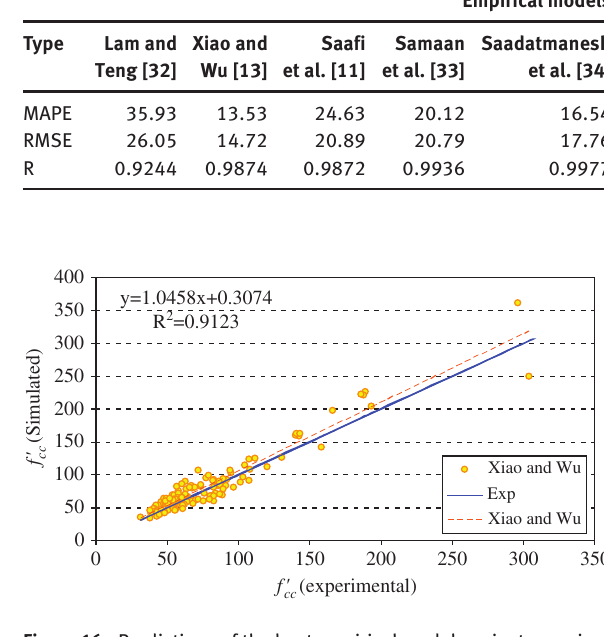
Figure 16 Predictions of the best empirical model against experi- mental